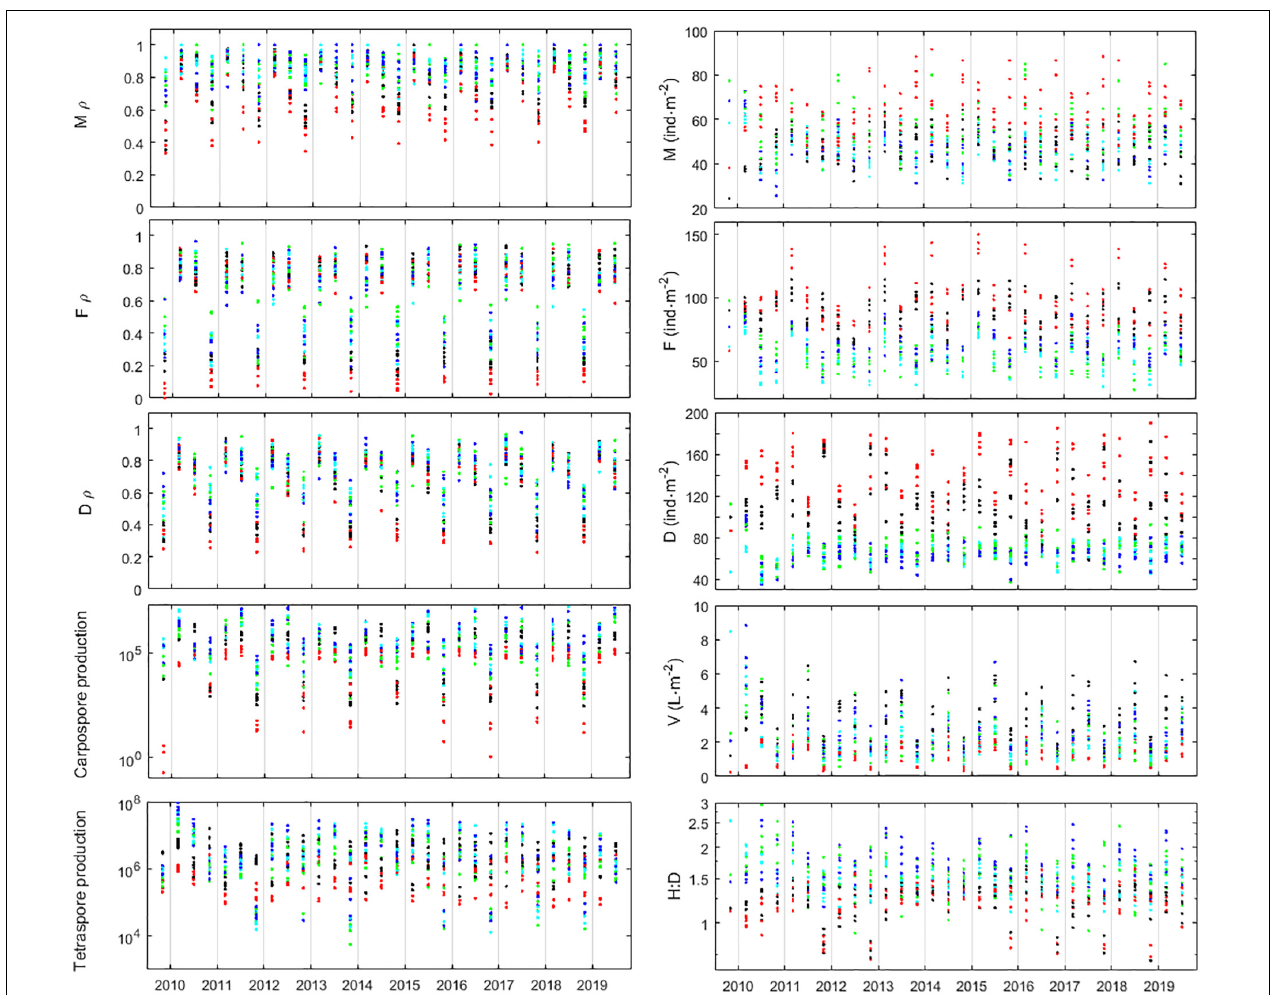
FIGURE 12 | Simulations of the A. chilense demography using the full IBM. Left panels show the fertility properties, namely, the probabilities ( ρ ) of males (M), females (F), and diploids (D) becoming fecund and the productions of tetraspores and carpospores. Right panels show the abundances of males (M), females (F), diploids (D), stand bimass density (V), and ratio of haploids-to-diploids (H:D). Five runs of the IBM are shown, simulating 10 years, starting October 2009. Simulations are stochastic from February 2012 onward. Markers represent plots Corral 1 (black), Corral 2 (red), Niebla 1 (green), Niebla 2 (light blue), and Niebla 3 (dark